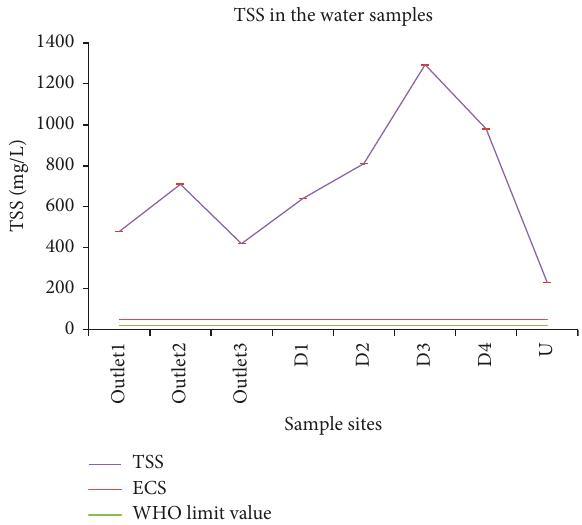
Figure 5: Comparison of TSS of the wastewater from the Zenzelma campus with the Ethiopian effluent discharge limit value and WHO